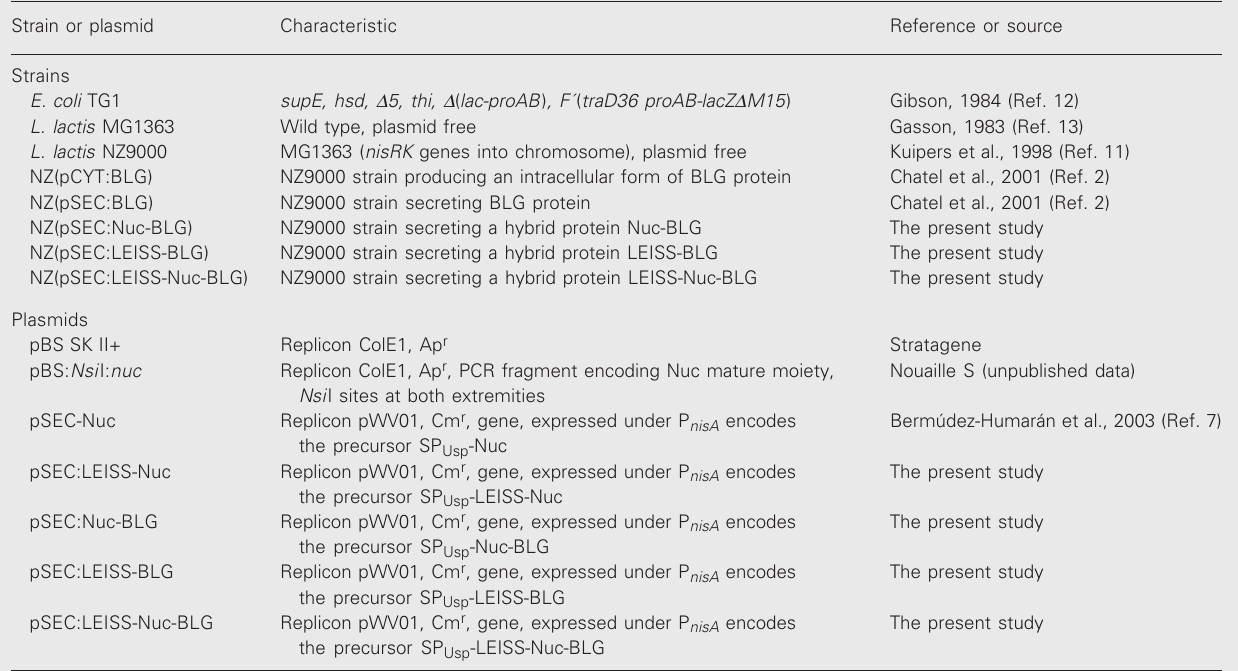
Table 1. Bacterial strains and plasmids used in the present study. Strain or